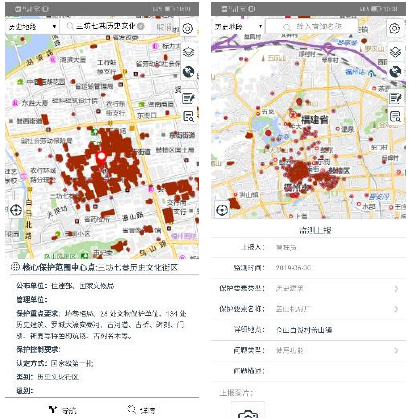
Figure 10. APP for historic city